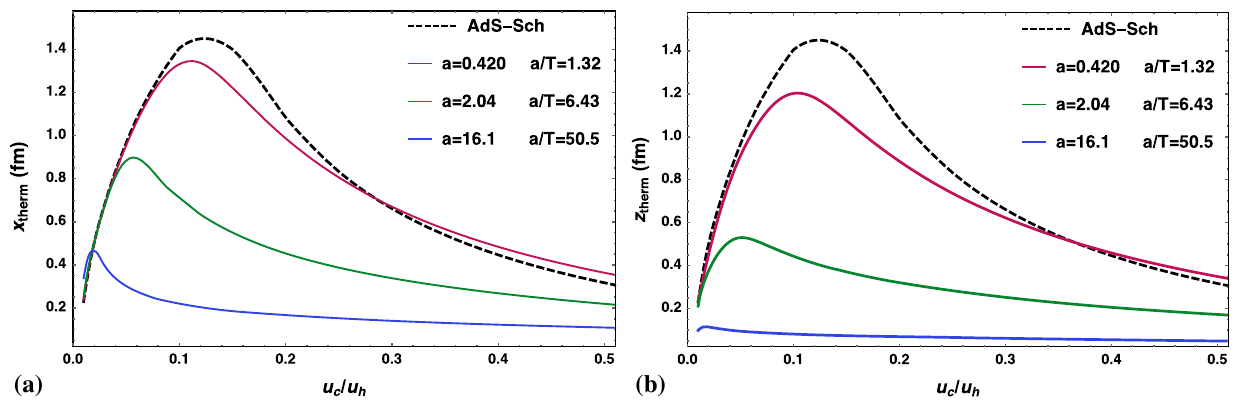
Fig. 5 The maximum stopping distance of the jet moving a in the x-direction and b in the z-direction in the anisotropic background with different anisotropy parameters. The anisotropic plasma has the same temperature as the isotropic plasma, T = 318 MeV. In all cases, the